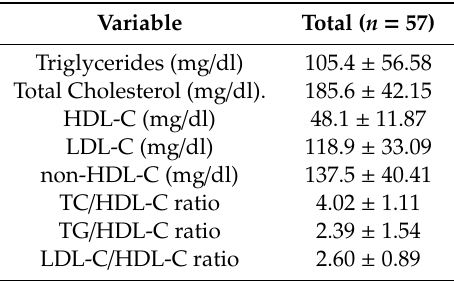
Table 3. Lipid profile and atherogenic ratios of the study sample.